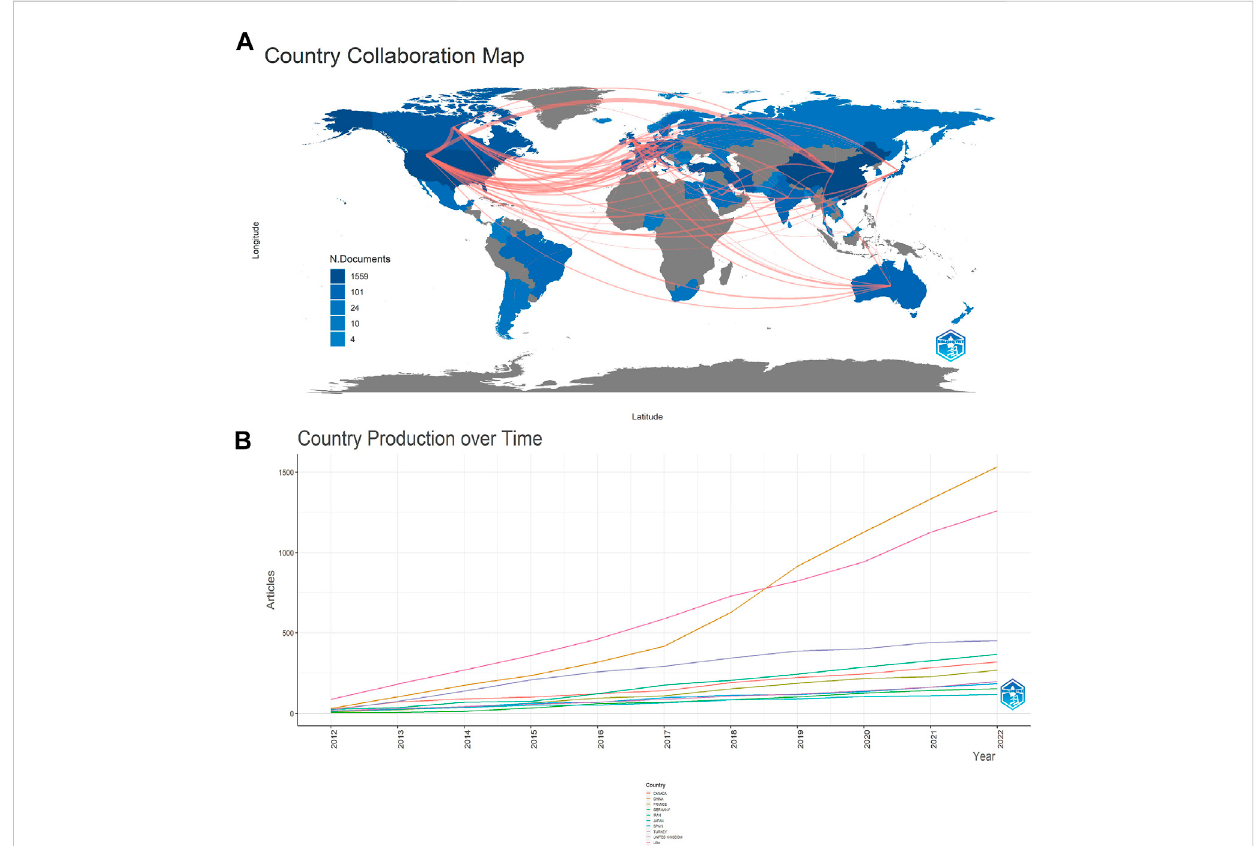
Analysis of the distribution of countries and publications. (A) Map of cooperation between SCI and electroactive materials countries (gray, no relevant publications in the country; blue, the country has relevant publications; blue depth, number of publications; red line, cooperation between connected countries, line thickness, frequency of cooperation); (B) Change in the number of publications in the 10 countries with the most publications from 2012 to 2022.